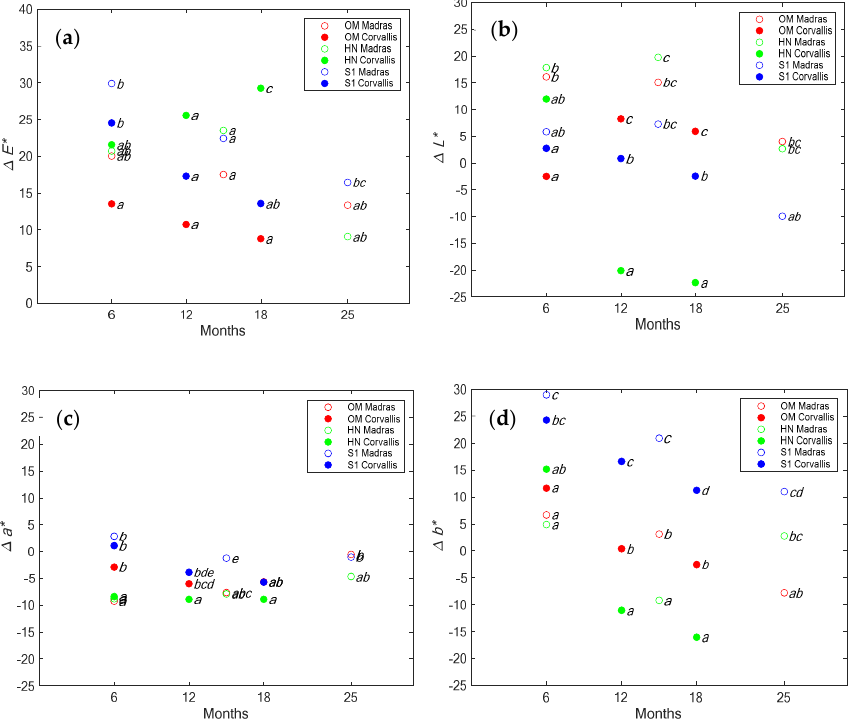
Figure 10. Games–Howell pairwise mean differences in ∆ E , ∆ L* , ∆ a*, and ∆ b* for each species/coating combination from each location during study for acetylated wood. Values with the same letter indicate that means between intervals did not differ significantly at p < 0.05. ( a ) color change ( ∆ E) , ( b ) ∆ L* , ( c ) ∆ a* , ( d ) ∆ b* .